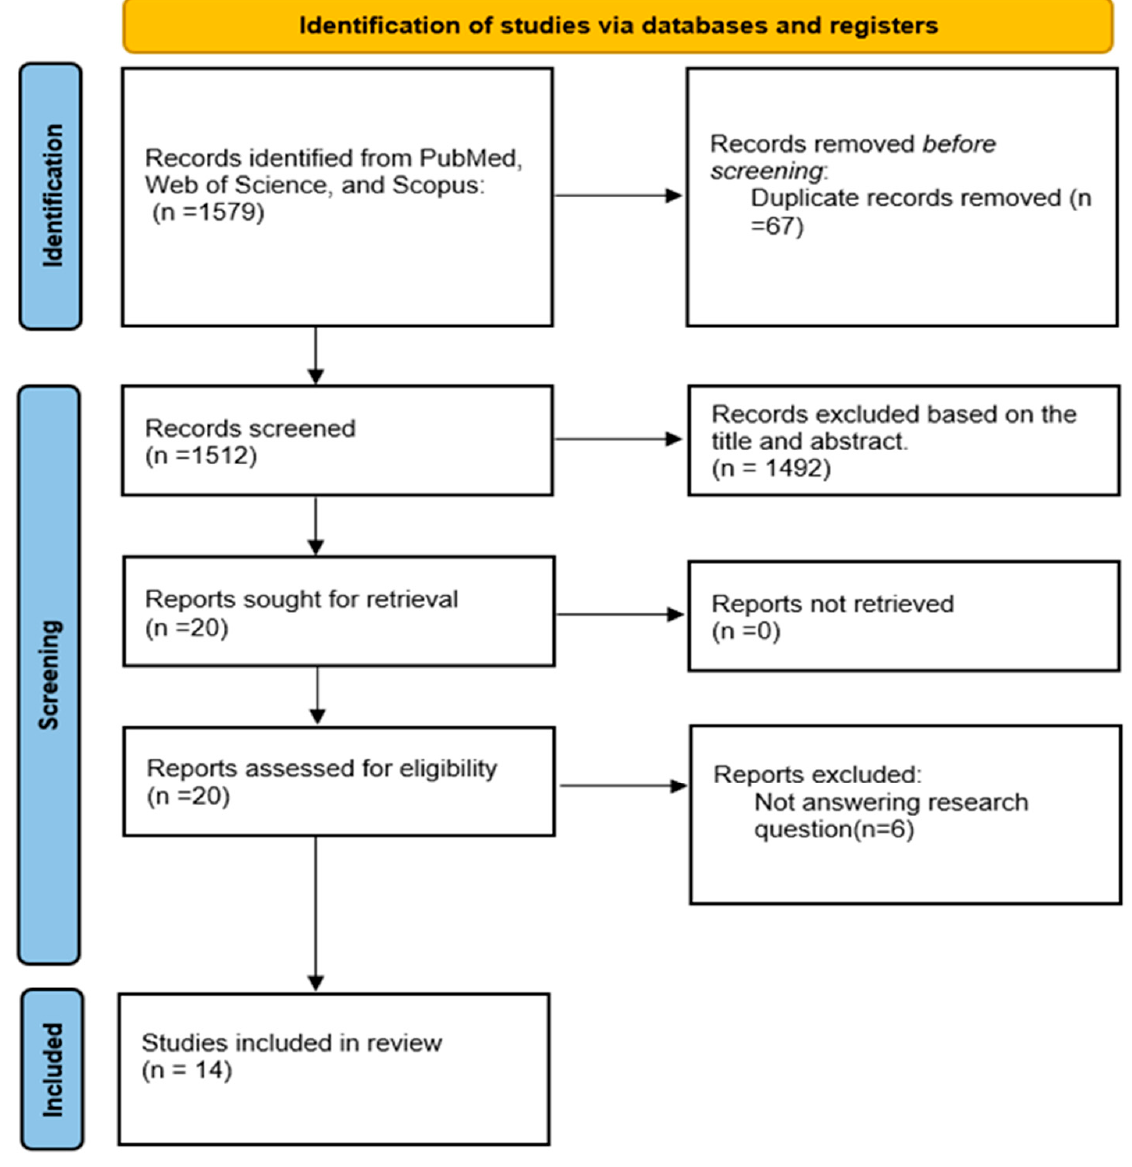
Figure 1. PRISMA flow